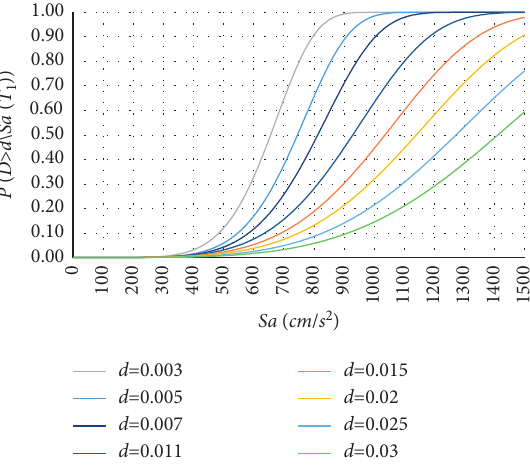
Figure 11: Fragility curves for the 12-story